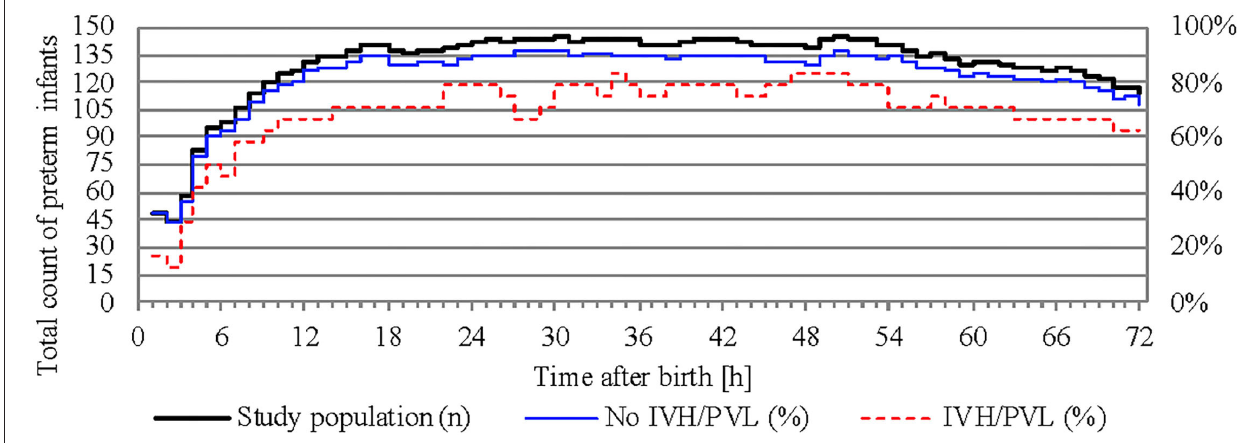
FIGURE 2 | Total count of preterm infants recorded over time and percentage of calculated mean cStO 2 . The study population is represented on the left y-axis, outcome groups are represented on the right y-axis.